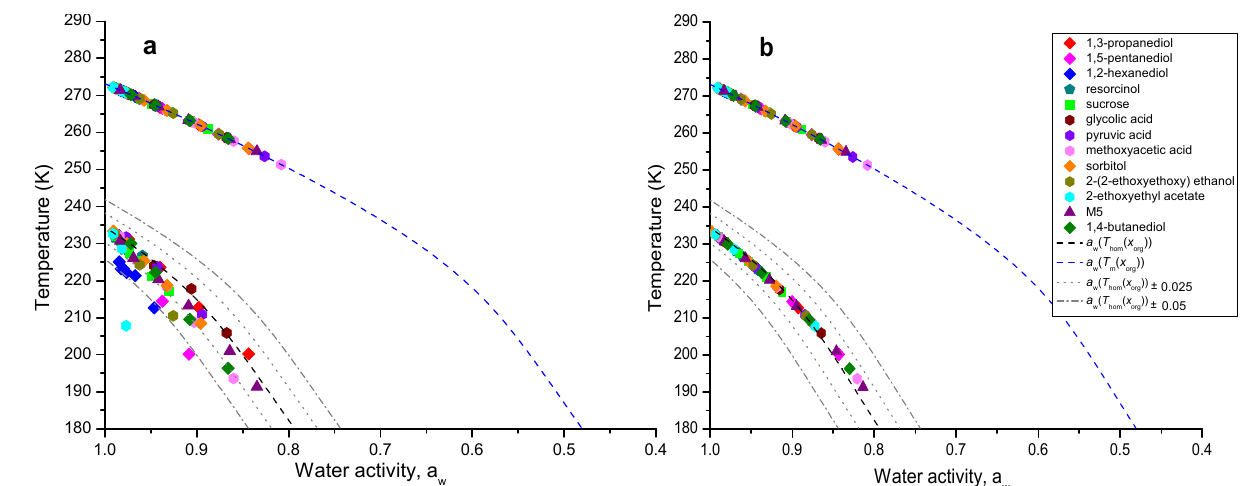
Figure 6. Homogeneous freezing T hom (x org ) and melting points T m (x org ) as a function of a w for various aqueous organic solutions. The blue dashed line in (a, b) is the homogeneous ice melting curve (T m ) (Koop and Zobrist, 2009). The black dashed line is the homogeneous ice freezing curve (T hom ) calculated by shifting the melting curve by 1a w = 0 . 313 (Koop and Zobrist, 2009). The grey dotted line and grey dash–dotted lines indicate a deviation of 2.5 and 5% in a w , respectively. In (a) , a w at T hom (x org ) is taken to be equal as a w determined at T m (x org ) i.e. with the assumption that there is no significant change in a w with temperature from T m (x org ) to T hom (x org ) . In (b) , a w at T m (x org ) is determined using Eq. (3) and the corresponding a w at the freezing temperature is estimated by using Eq. (3) at T hom (x org ) with a constant 1a w = 0 . 313 added to the a w value determined on the melting